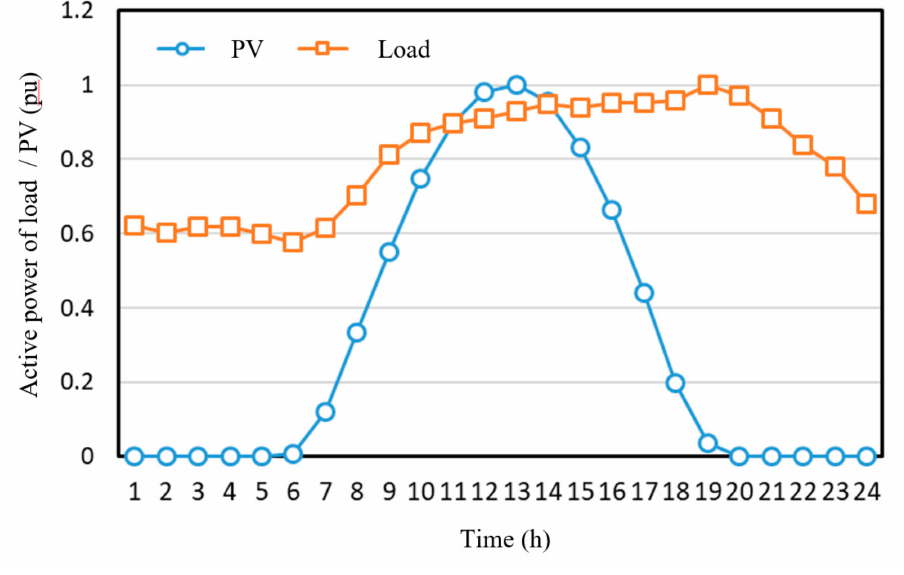
Figure 12. Time variation in the active power of load and PV.